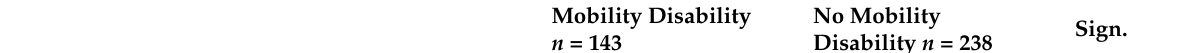
Mobility Disability n = 143